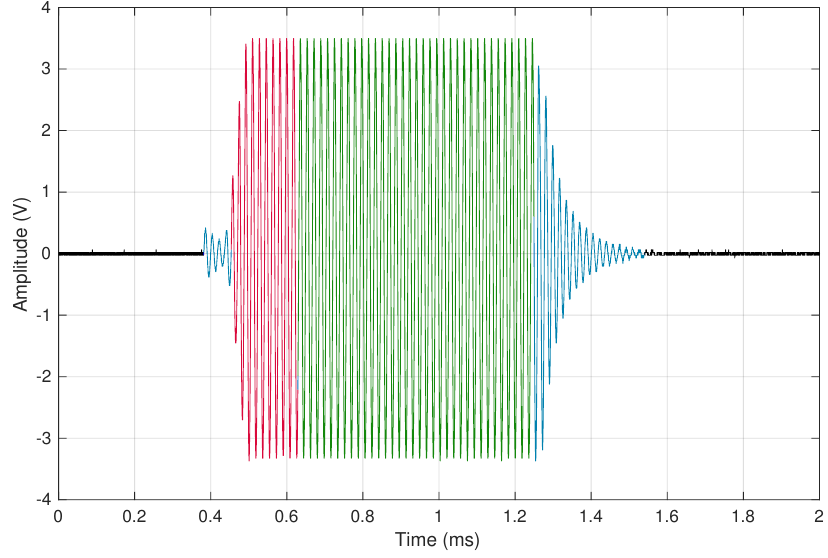
Figure 13. Capturing of a measurement of the coil